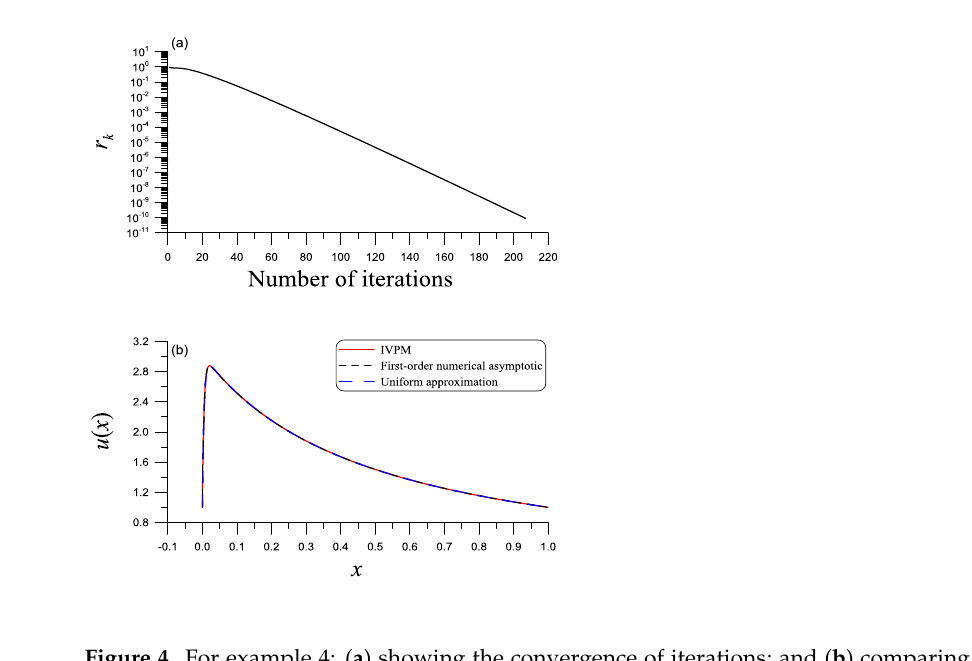
Figure 4. For example 4: ( a ) showing the convergence of iterations; and ( b ) comparing the exact solution, a uniform approximation and the present first-order